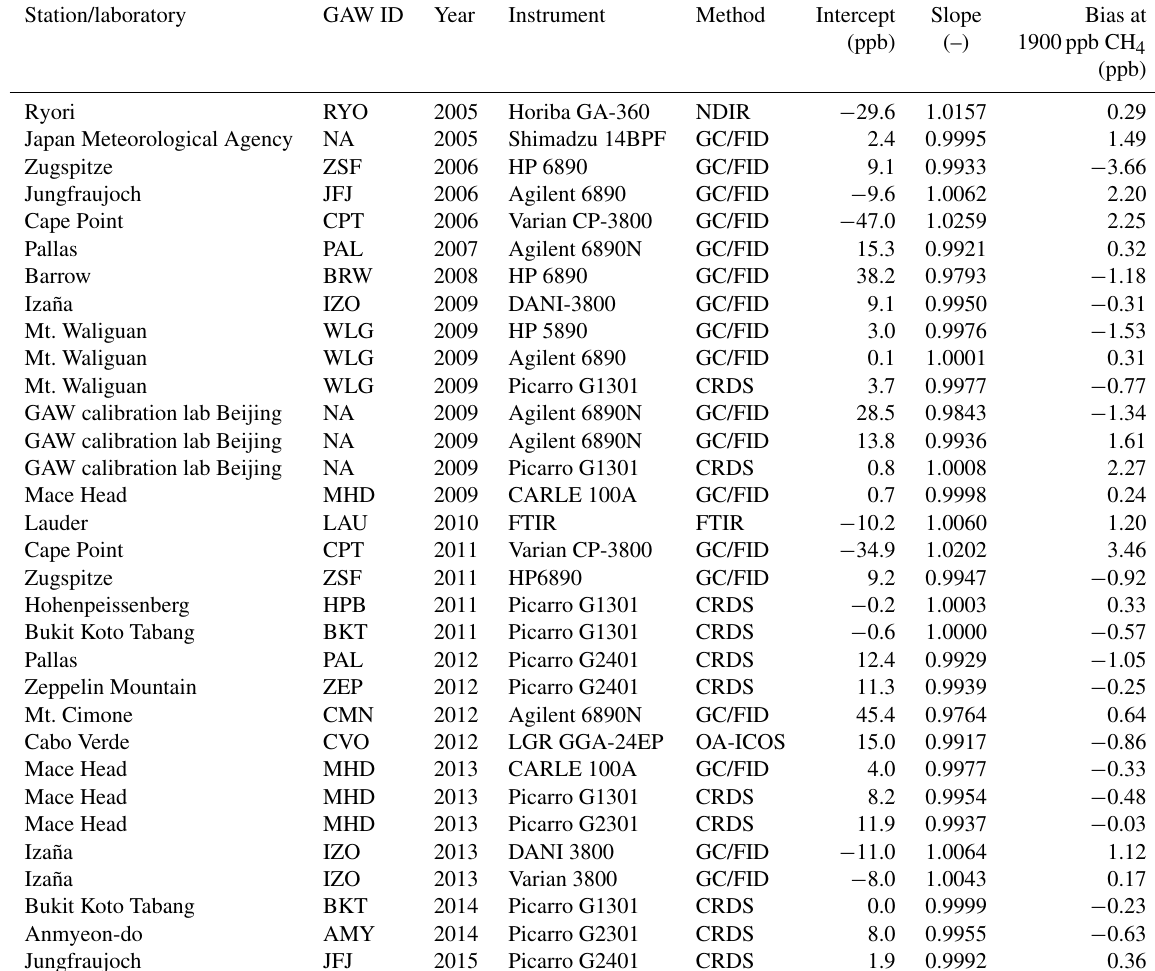
Table 2. CH 4 performance audits using travelling standards from 2005 to 2014.